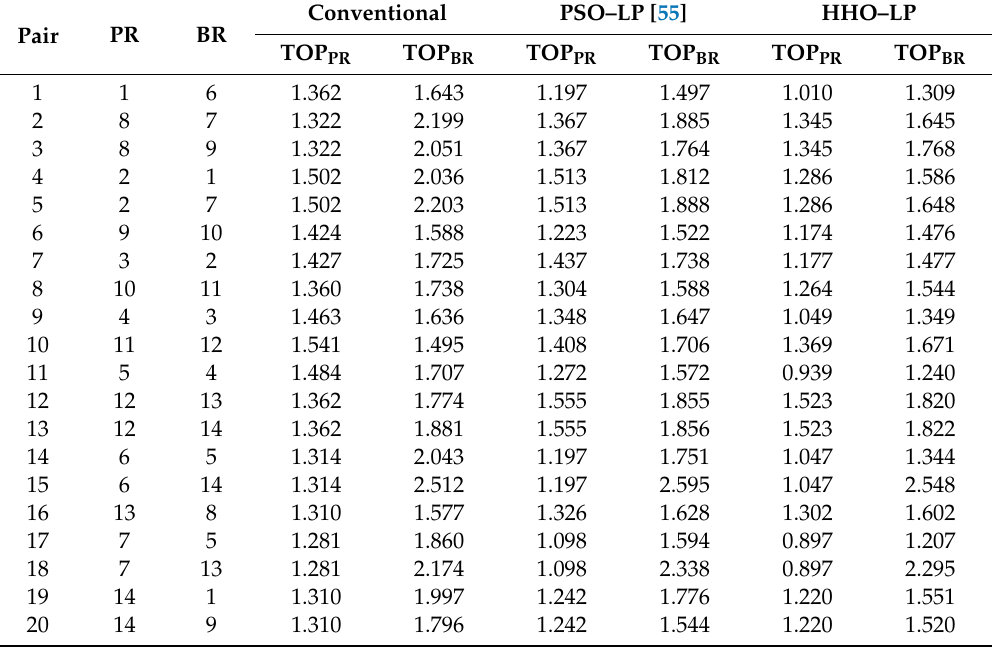
Table 5. Operation time (TOP) of primary and backup relays for all pairs of IEEE-8 bus system with conventional settings and those updated with PSO–LP and